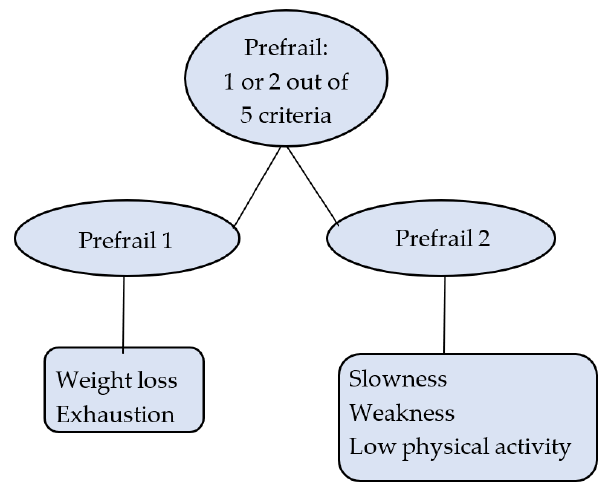
Figure 1. Prefrailty